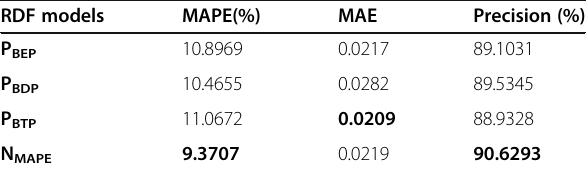
Table 7 Precision of n-mode and p-mode models RDF models